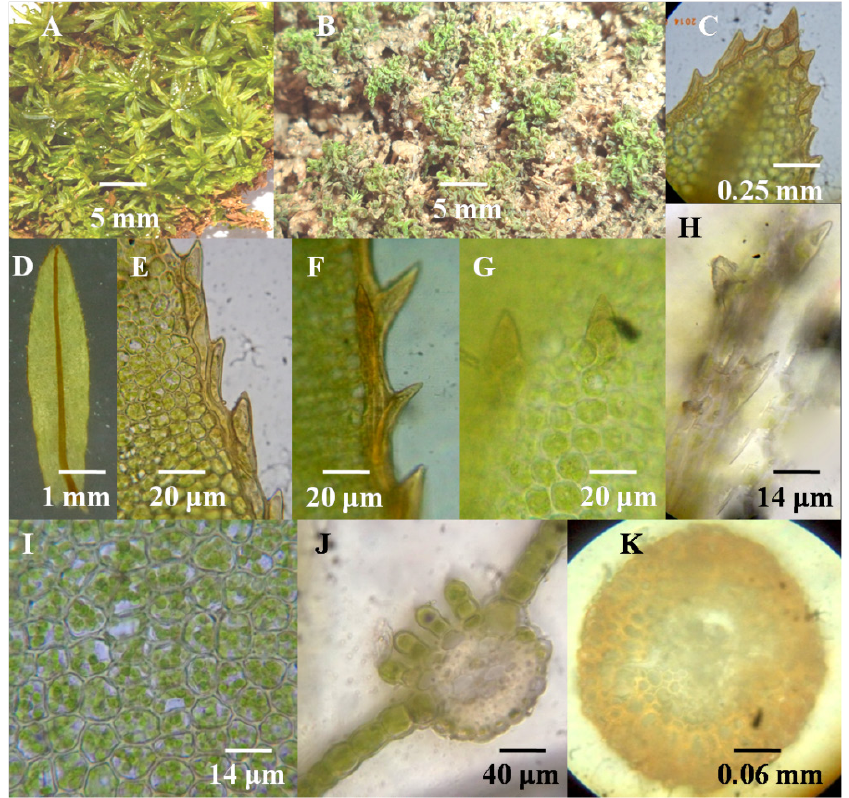
Figure 4: Atrichum crispulum Schimp. Ex Besch.(A) freshhabit (B) dry habit, (C) leaf tip, (D) vegetative leaf, (E) leaf marginal cells, (F) leaf margin with two rows of marginal teeth, (G) teeth on leaf lamina, (H) teeth on back side of costa, (I) leaf lamina cells, (J) transverse section of leaf, (K) transverse section of